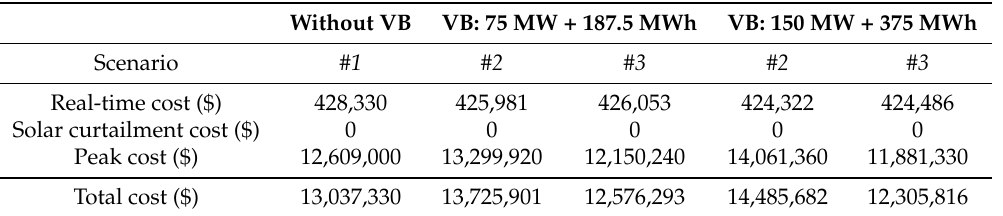
Table 1. Economic benefits of grid market layer (GML).